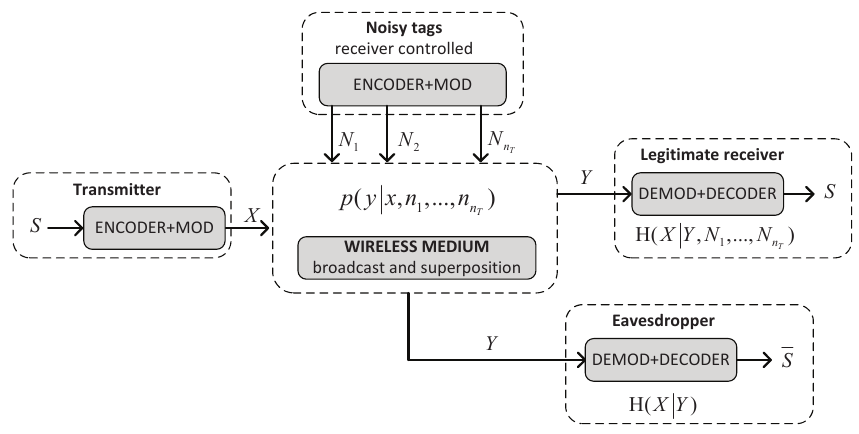
Figure 3. A model for the wiretap channel with noisy